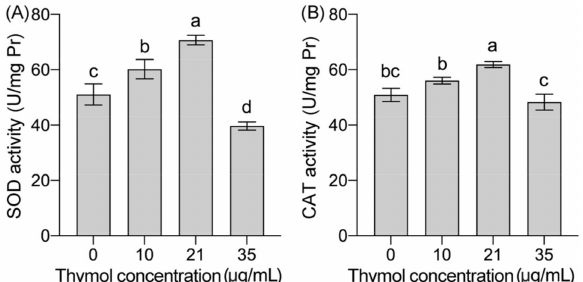
Figure 6. Effect of thymol on the activity of antioxidative enzymes in the mycelia of FON . The mycelia were treated with thymol (0, 10, 21, and 35 µ g/mL) for 24 h. Then the mycelia were collected for the assay of ( A ) SOD activity and ( B ) CAT activity. Bars indicated SD of three replicates. Different lowercase letters indicated significant difference among different treatments (LSD, n = 3, p <